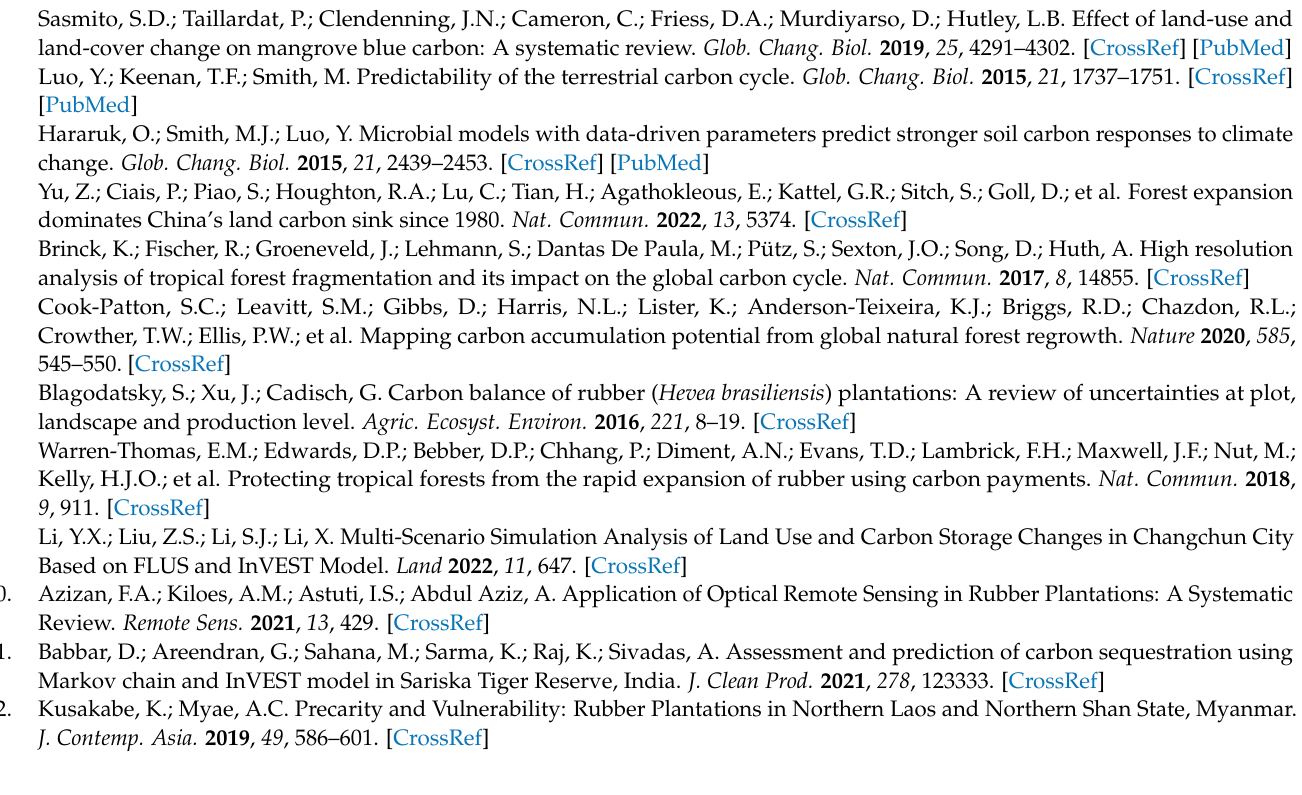
imagery; Table S2: Carbon density of each component in different land-cover types in different years (units: t/ha); Table S3: Confusion matrix of the forest and rubber plantation mapping; Table S4: Confusion matrix of identification results of rubber planting years.; Figure S1. Importance statistics of spectral features. References [84–94] are citied in the Supplementat